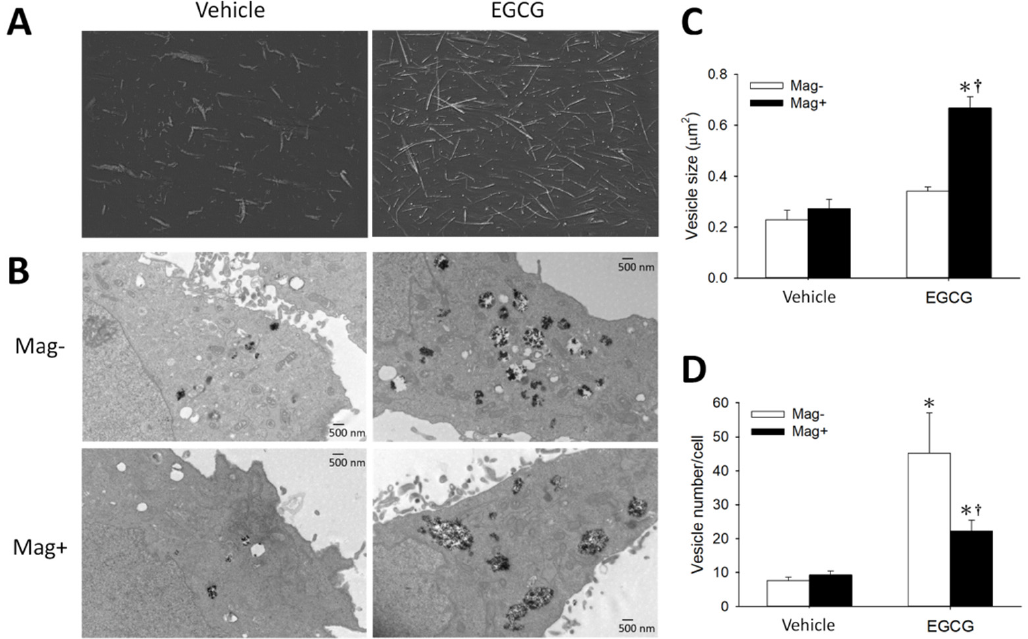
Figure 2. EGCG-enhanced MNP aggregation and internalization by glioma cells. ( A ) MNP aggregates in cell-free medium were observed by 3D Cell Explorer with or without EGCG for 2 h. ( B ) U87MG cells were incubated with dextran-MNPs (100 μ g/mL; 25 μ g/cm 2 ) and EGCG (10 μ M) in the absence (Mag − ) or presence (Mag+) of the magnet for 24 h, followed by analysis with transmission electron microscopy. The vesicle size ( C ) and vesicle number ( D ) were analyzed from 6–8 cells in each group with (Mag+) or without (Mag − ) magnetic influence. Values are mean ± SEM ( n = 56–226). * , †, p < 0.05 compared with corresponding group without EGCG or magnetic field, respectively.